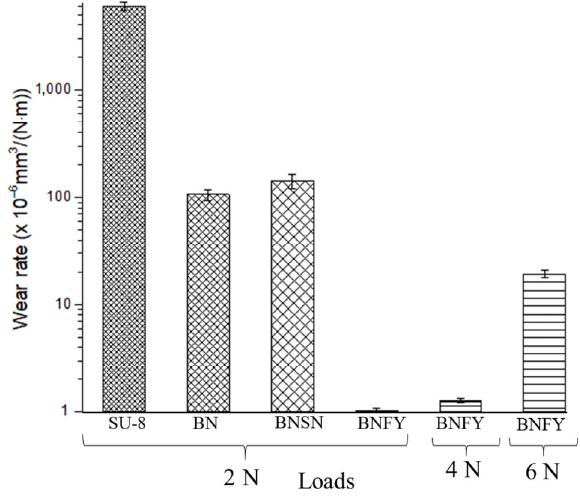
Fig. 12 Wear rate of SU-8 and its composites until failure of the coating at different normal loads and a constant 0.28 m/s sliding speed.